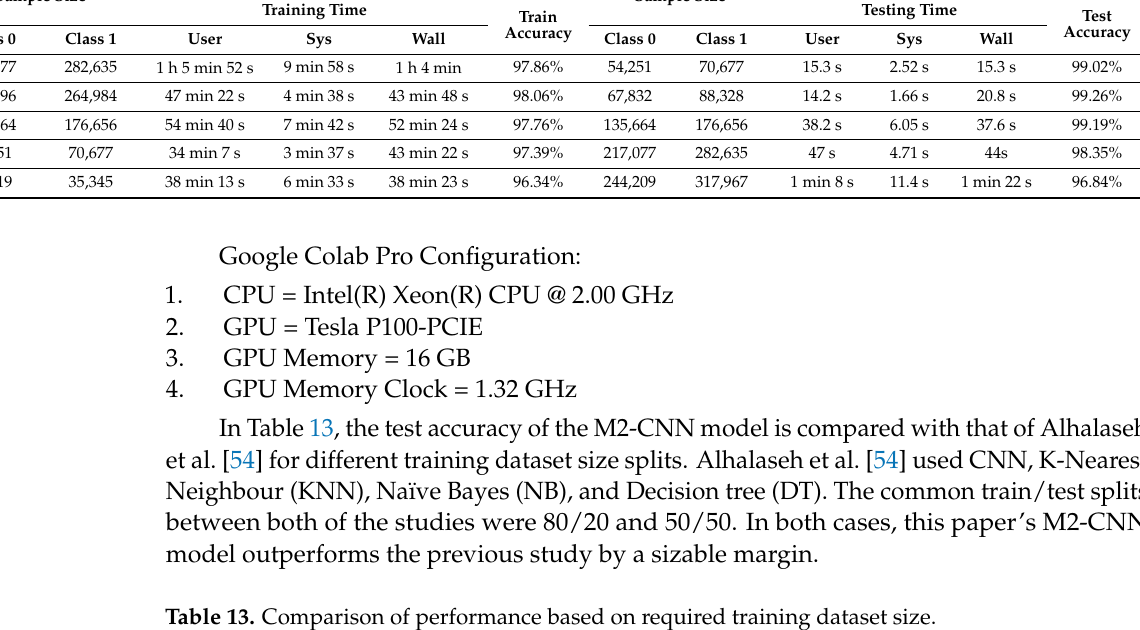
Table 13. Comparison of performance based on required training dataset